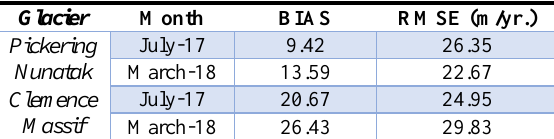
Table 2: Accuracy of the derived results.